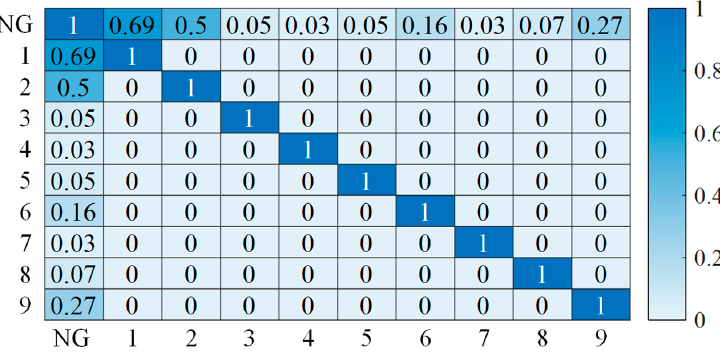
Figure 7. The principal components obtained by PCA (Xi’an case).